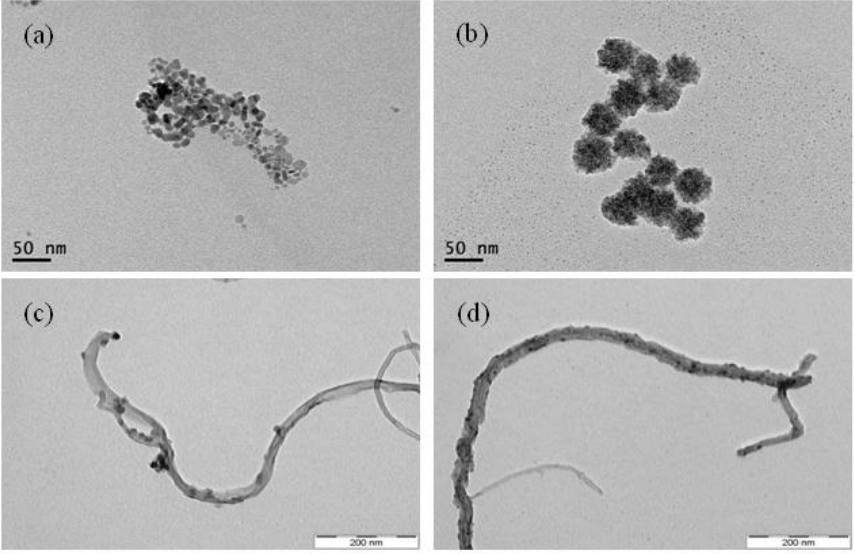
S-MWNT support (d) prepared by 2